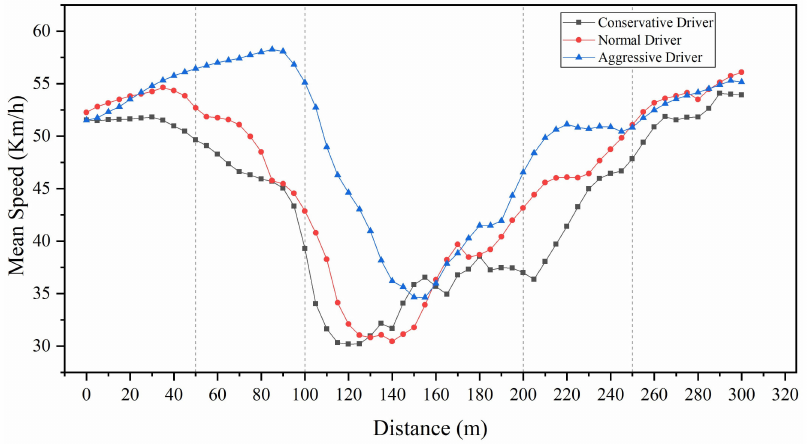
Figure 5. Mean speed for three type of